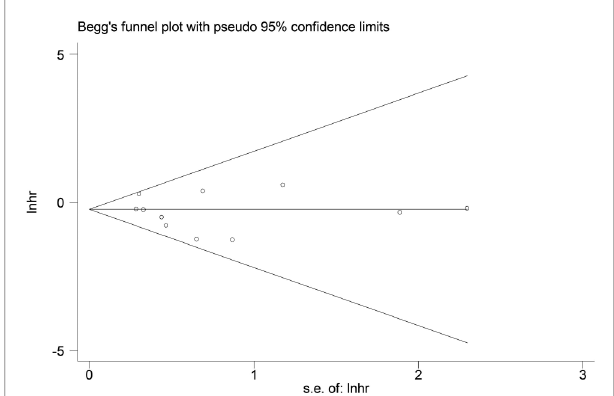
FIGURE 4 | Begg ’ s funnel plot.